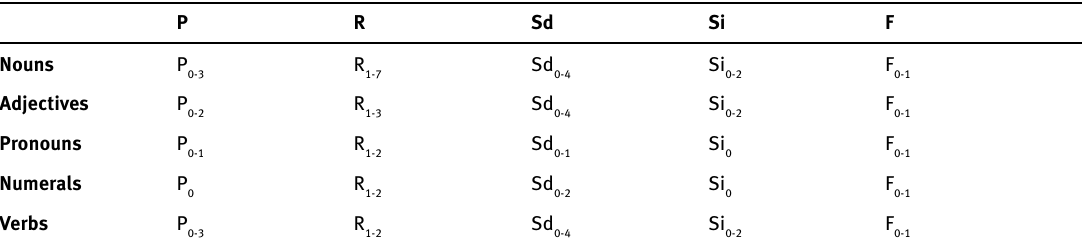
Table 4. Generalised Morphemic Structure of Nouns, Adjectives, Pronouns, Numerals, and Verbs P R Sd Si